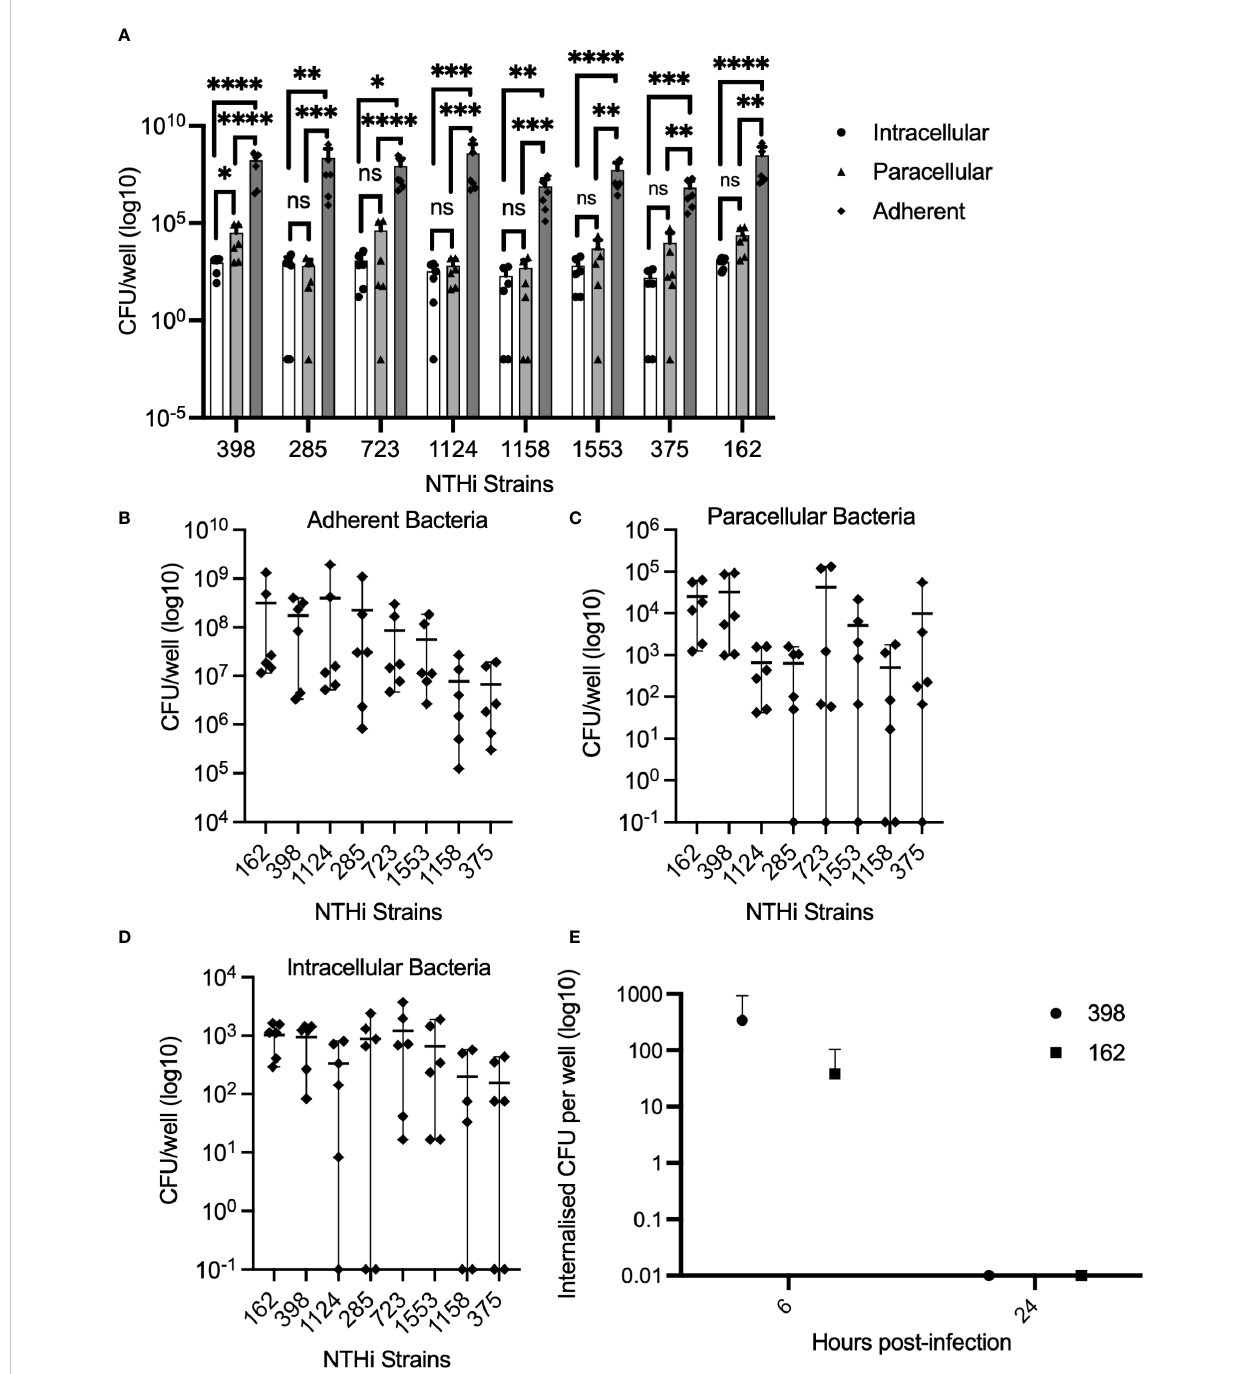
FIGURE 1 NTHi is temporarily internalized within the epithelial monolayer, and can invade intracellularly and paracellularly. Enumeration of bacterial adhesion and internalization into Calu-3 cells and the paracellular space following incubation with NTHi strains for 4 hours was performed. n=3 independent replicates, with dots representing the mean of technical duplicates for each independent experiment (A – D) . (A) Adherent bacteria account for >99% of bacteria interacting with epithelial cells. By 2-way ANOVA, there was overall a signi fi cant difference between number of intracellular bacteria and adherent bacteria, and between paracellular and adherent bacteria numbers by 2-way ANOVA (p<0.0001). Results from Sidaks post-hoc test is indicated for individual strains. (B) Numbers of adherent bacteria varied signi fi cantly between strains. Overall difference between strains by 2-way ANOVA, p<0.0001. (C) Numbers of paracellular bacteria did not differ signi fi cantly between strains by 2-way ANOVA. (D) Numbers of internalized bacteria varied signi fi cantly between strains. Difference between strains by 2-way ANOVA, p=0.0003. (E) NTHi does not persist within PBECs in ALI culture in the absence of extracellular bacteria. Viable internalized bacteria of strains 398 and 162 were detectable at 6 hours by culture of lysed cells, but not at 24 hours post-infection in cells grown at ALI and maintained in media containing gentamicin to eliminate replication by extracellular bacteria in the media. Dots represent means of n=3 biological replicates from healthy control donors. Difference between time points not signi fi cant by 2-way ANOVA and post-hoc Sidaks multiple comparisons test. Throughout, **** corresponds to P ≤ 0.0001, *** indicates P ≤ 0.001, ** means P ≤ 0.01, * indicates ≤ 0.05, anything P > 0.05 is